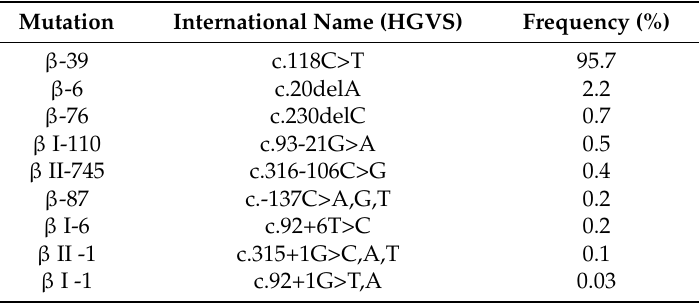
Table 1. Frequency of β -thalassemia mutations in